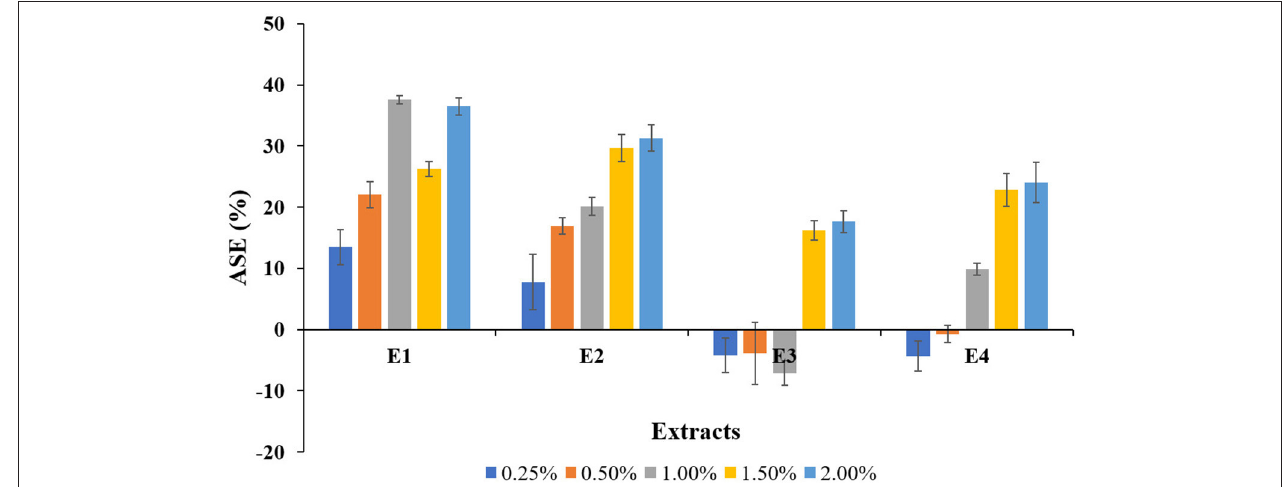
FIGURE 1 | Anti-shrink efficiency (ASE) values for the plant extracts treated wood blocks of Lannea coromandelica .